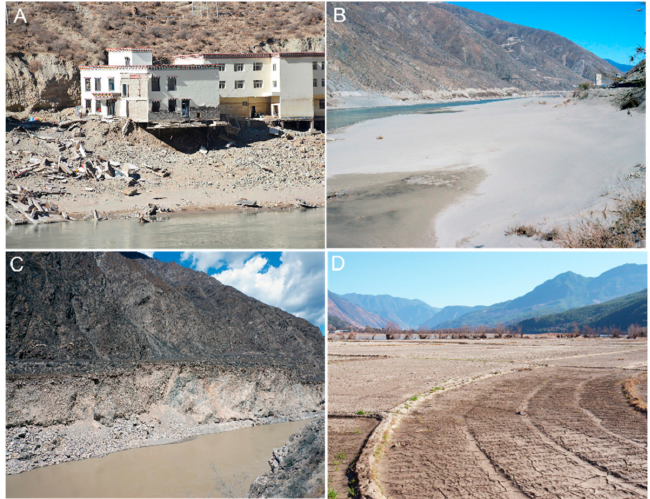
Figure 13. Damage photos of scouring and silting after the flood. ( A – D ) correspond to areas in Figure 9,